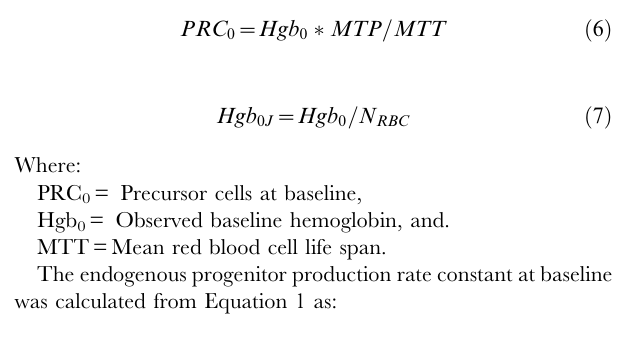
PRC 0 = Precursor cells at baseline, Hgb 0 = Observed baseline hemoglobin, and. MTT = Mean red blood cell life span. The endogenous progenitor production rate constant at baseline